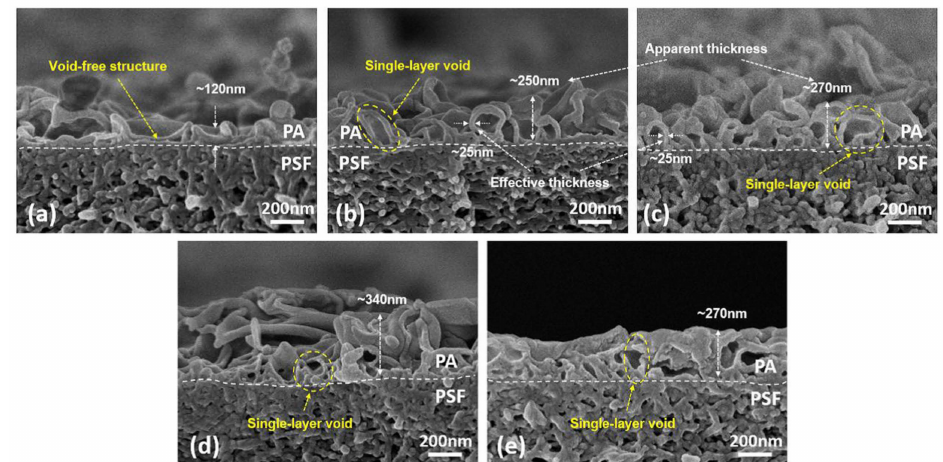
Figure 5. Scanning electron microscopy (SEM) images of the cross-section of the TFC membrane prepared at various TMC concentrations (MPD concentration is fixed at 2%). ( a ) 0.01%, ( b ) 0.05%, ( c ) 0.1%, ( d ) 0.2%, ( e ) 1%. Reproduced from reference [60] with permission from Elsevier